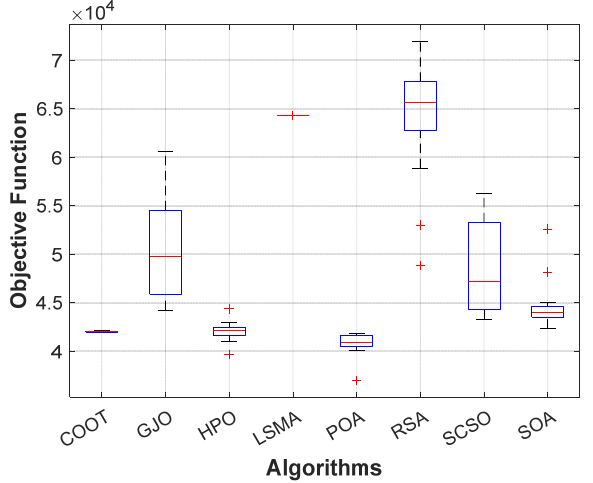
Figure 30. Boxplot of POA and other compared algorithms for case 5 in a standard IEEE 57-bus test system.